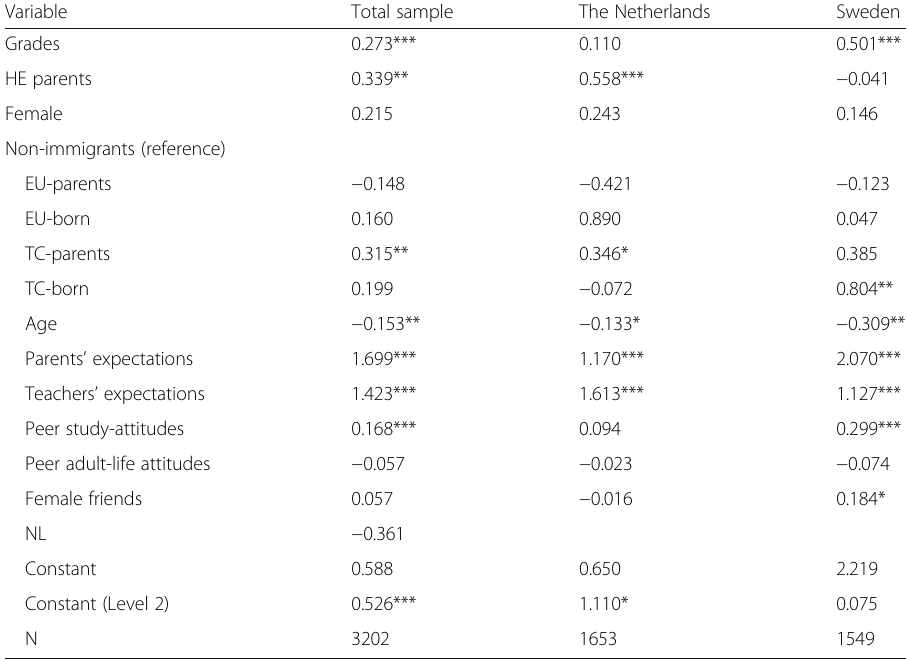
Table 2 Multi-level logit regressions of doxic university